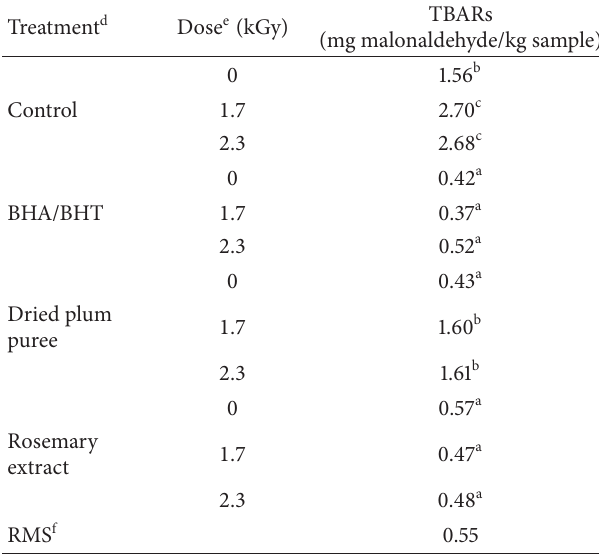
Table2:LeastsquaremeansforTBARsvaluesofgroundbeefpatties with/without antioxidants and irradiated at two dose levels.